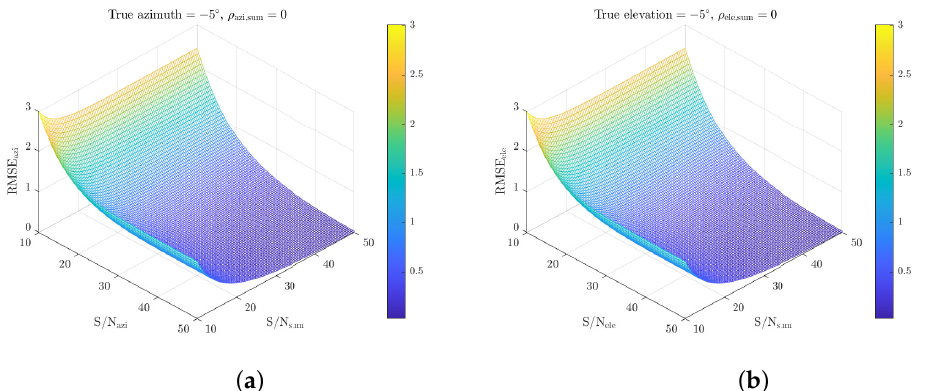
Figure 14. RMSE for difference channel SNR and sum channel SNR ( θ azi , θ ele = − 5 ◦ , ρ azi,sum =